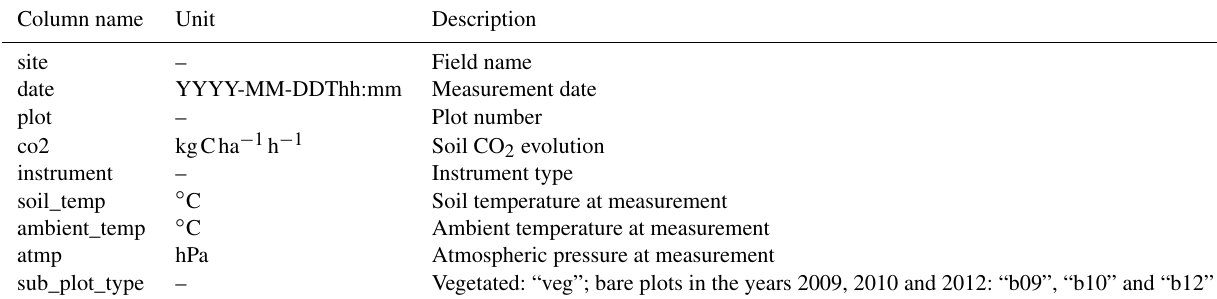
Table 18. Determined chamber flux measurements; the suffixes are identical to the ones in Table 9, as are the plot references here and in the data